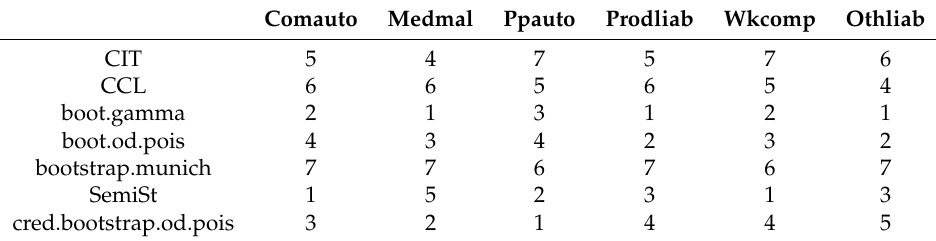
Table 16. Combined rankings of stochastic reserving methods per business line. (Excluding